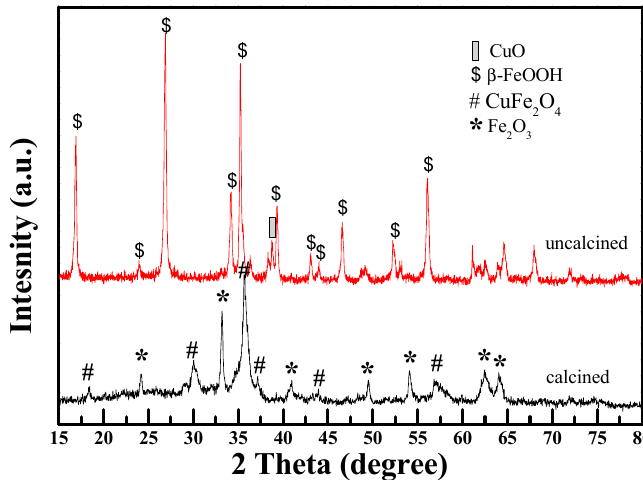
Figure 1. XRD patterns of the uncalcined and calcined precursors prepared by the aqueous precipitation method.